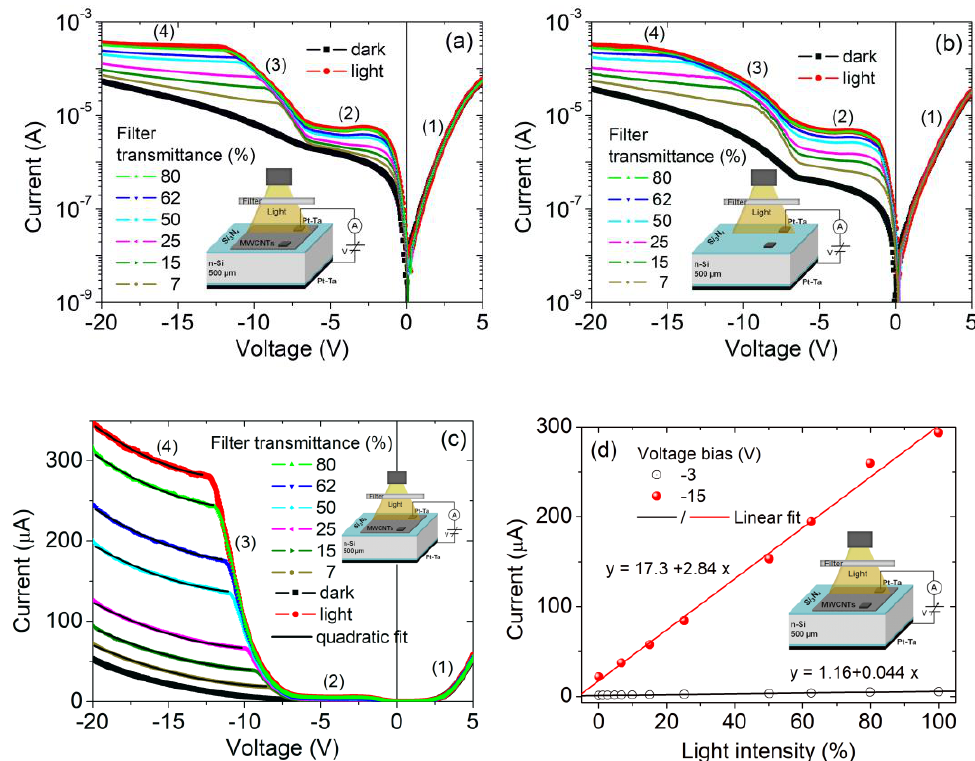
Figure 4. I-V characteristics of the Pt - Ta_CNT/Si 3 N 4 /n-Si/Si 3 N 4 /Pt - Ta ( a ) and Pt - Ta_CNT/Si 3 N 4 /n-Si/Si 3 N 4 /Pt - Ta. ( b ) Metal - insulator - semiconductor - insulator - metal (MISIM) heterostructures in the dark and under different degrees of illumination, on a semilogarithmic scale. ( c ) I-V characteristics on a linear scale. ( d ) Reverse current at – 3 V and – 15 V as a function of the illumination intensity (percentage) of the Pt - Ta_CNT/Si 3 N 4 /n-Si/Si 3 N 4 /Pt - Ta structure.